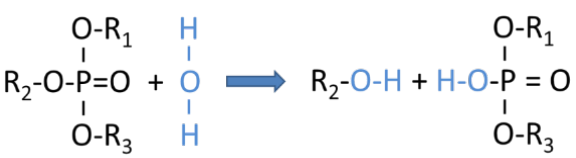
Figure A2. Exchange of water- into phenol / butanol - bonded OH groups and partial phosphates as dissolved water is used up in molecular fragmentation events. A shift in the resonance frequency occurs as the force constants (bond strength) and the reduced masses of the molecular oscillators are changed [44].